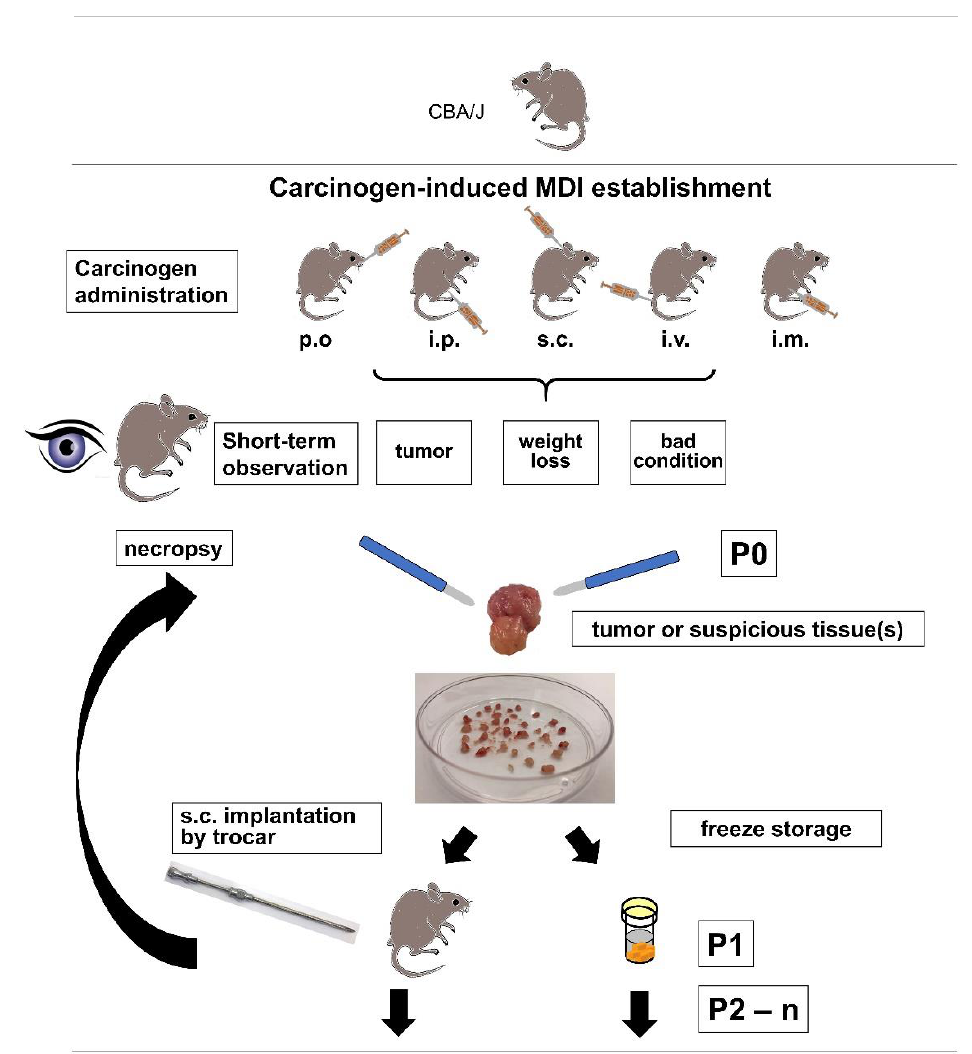
Figure 1. Scheme of cMDI establishment. Various carcinogen administration routes, as well as termination criteria, and general handling of tumor or other suspicious tissue samples are schematically summarized (P: passage numbers; P0: primary necropsy; P1: first passage of primary tumor; P2 – n: second and further follow up passages).